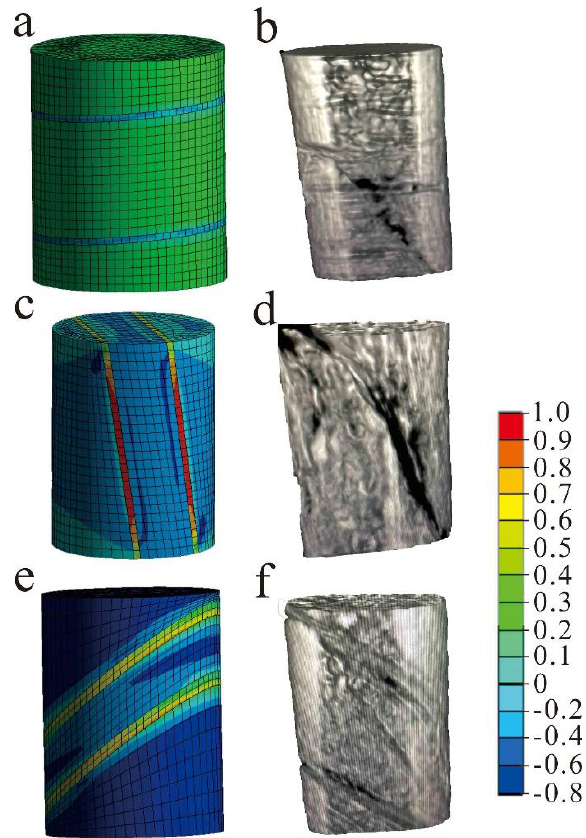
Figure 6. Finite element simulation results of the bedding fractures (i.e., lamina-induced fractures) and the computerized tomography (CT) photos of the fractured laminated samples. The color code for the finite element simulation results of ( a , c , e ) indicates the fractured index based on the modified T–K criterion. ( b , d , f ) show the CT photos of fractured samples, and the darker color indicates a bigger fracture aperture.